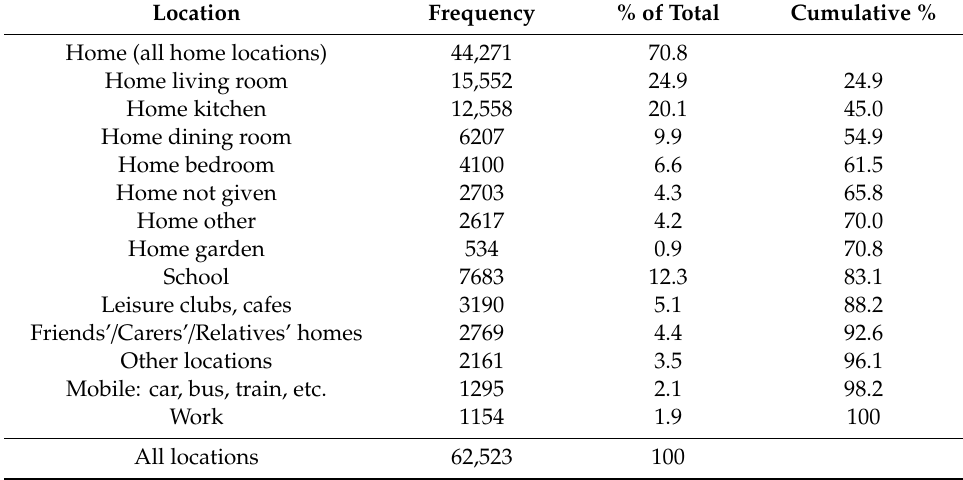
Table 3. Distribution of total adolescents’ food diary entries by eating location in the 2008–2012 NDNS sample